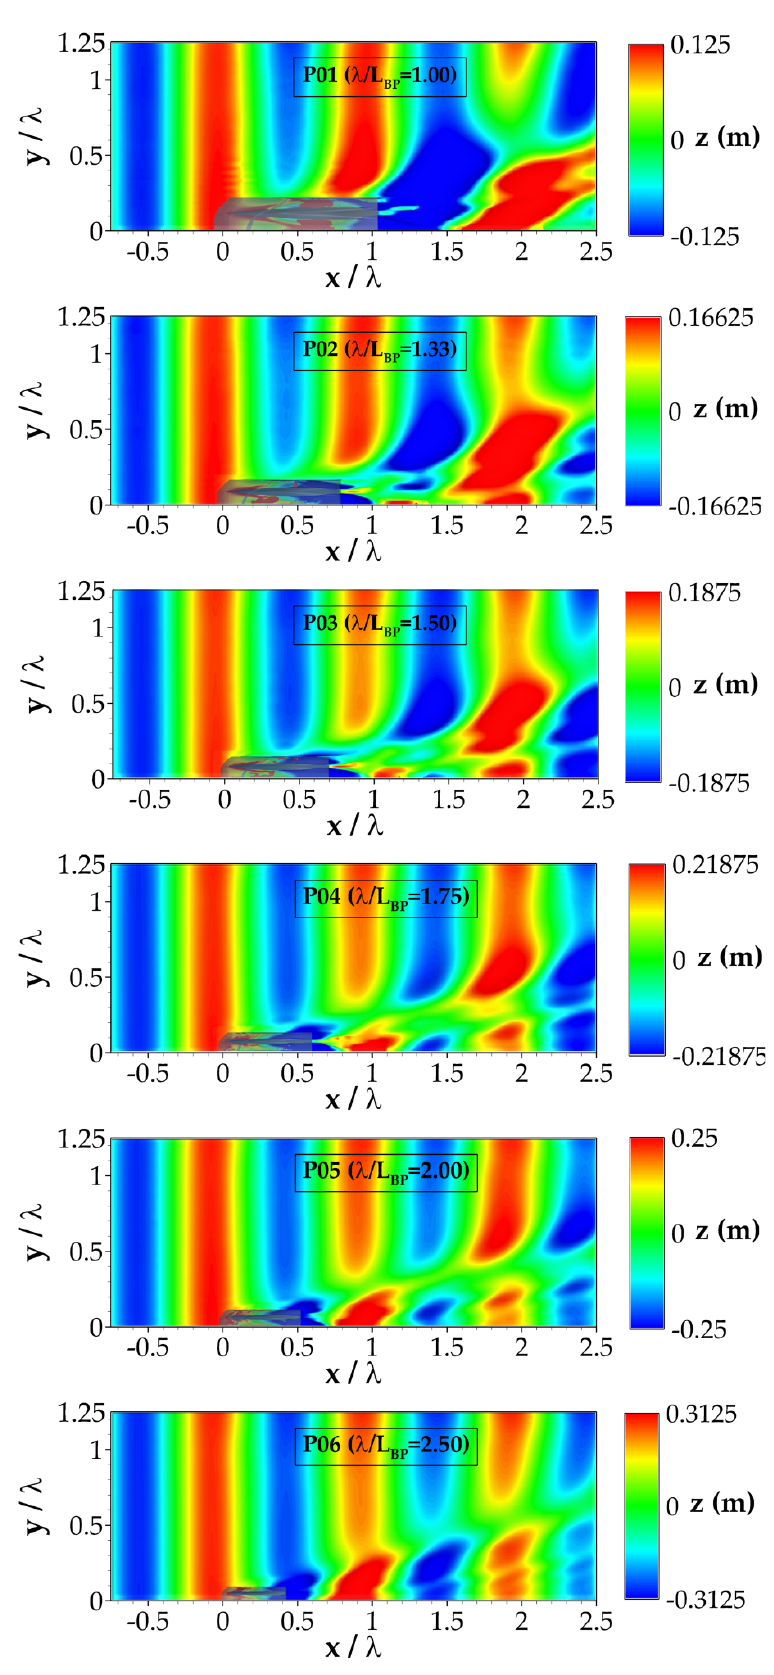
Figure 15. The free surface deformations of the Double-M craft in head wave conditions at T e / T = 0 .